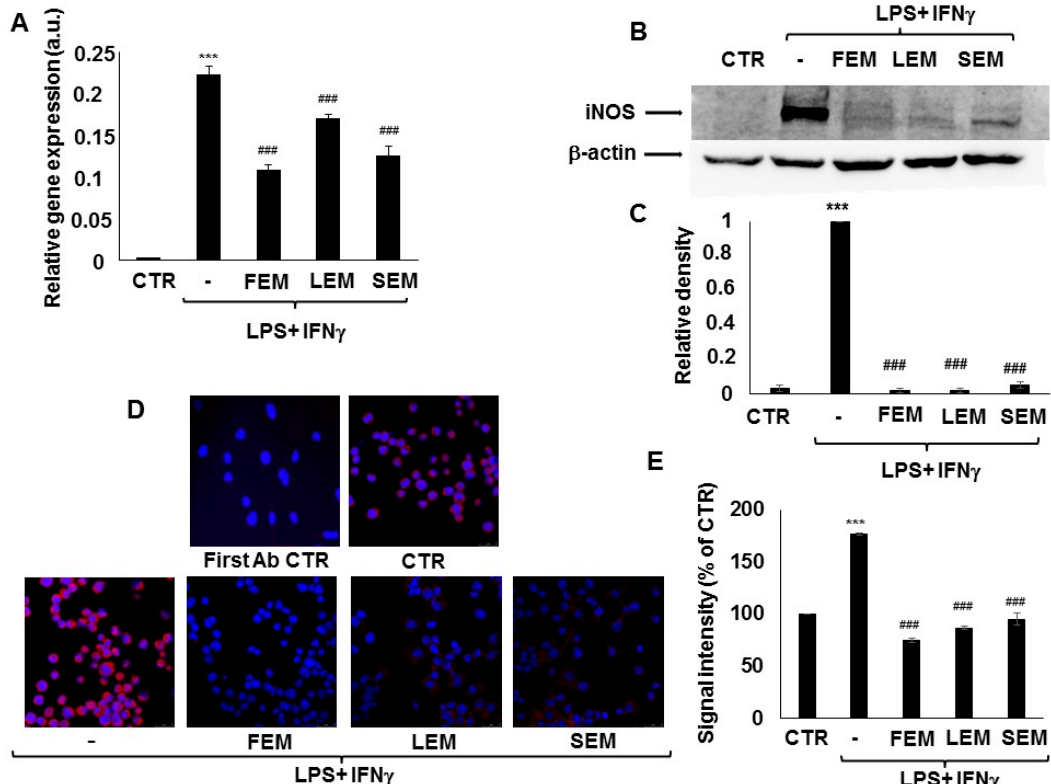
Figure 2. Flower (FEM), leaf (LEM), or stem (SEM) extracts of S. acmella mitigate expression of iNOS mRNA and protein in LPS + IFN γ -treated RAW264.7 macrophages. ( A ) RAW264.7 cells (CTR) upregulated relative gene expression of iNOS upon activation with 10 ng/mL LPS + 10 ng/mL IFN γ for 24 h in absence of plant extract (0). When the cells were cultured in the presence of FEM, LEM, or SEM, iNOS mRNA expression was reduced by 30 – 50%. ( B ) iNOS protein expression was also induced upon activation with 10 ng/mL LPS + 10 ng/mL IFN γ for 24 h in the absence of plant extract (lane 2 vs lane 1). FEM, SEM and LEM almost completely abrogated iNOS upregulation when the cells were cultured in the presence of plant extract. ( C ) Relative densities of the iNOS bands were determined. ( D ) Microscope images showing immunofluorescent staining of RAW264.7 macrophages for iNOS (red) with nuclear counterstain (blue). 10 ng/mL LPS + 10 ng/mL IFN γ treatment for 24 h in the absence of plant extract enhanced iNOS staining. FEM, SEM, and LEM extracts reduced the iNOS signal to 40 – 45% compared to LPS + IFN γ activated macrophages. ( E ) Intensities of the immunofluorescent iNOS signals were quantified in ImageJ software. (* Stars indicate significant (*** p < 0.001) induction of iNOS mRNA (A) or protein (C, E) production by IFN γ + LPS. #Hashmarks indicate significant (# p < 0.05, ## p < 0.01, ### p < 0.001) reduction of IFN γ + LPS-induced NO production by the plant extracts.).